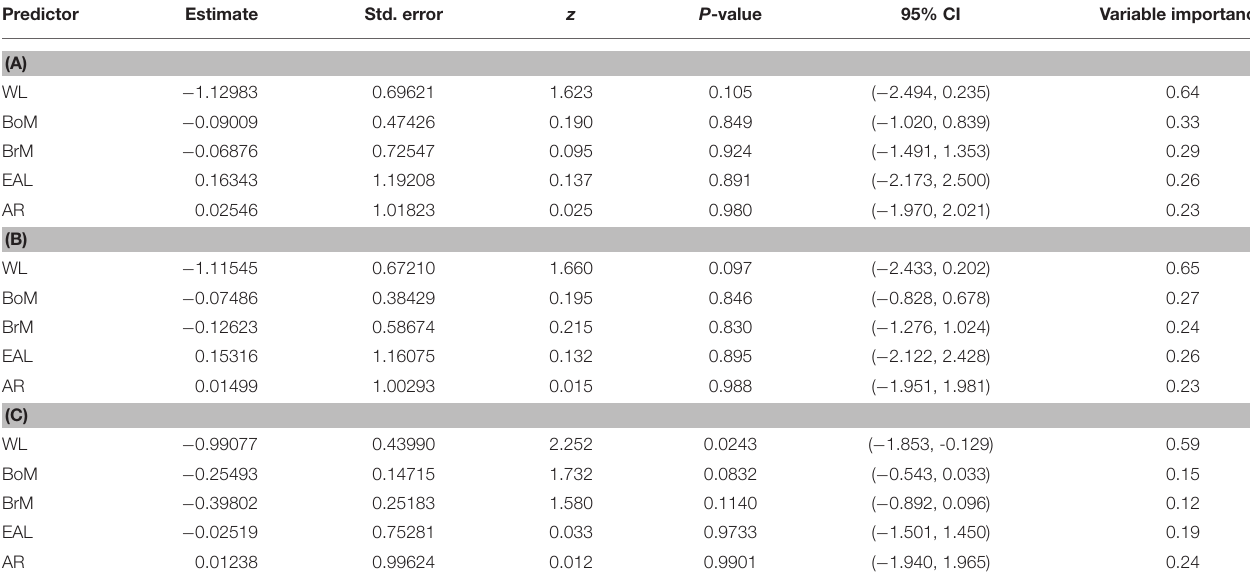
TABLE 4 | Model conditional average estimate of each parameter coefficient in each of the three scenarios considered: (A) 32 models including all variables irrespective of the degree of correlation between pairs of predictors, (B) 24 models removing those that contained any two predictors with a correlation ≥ 0.90, and (C) 12 models removing those that contained any two predictors with a correlation ≥ 0.70.